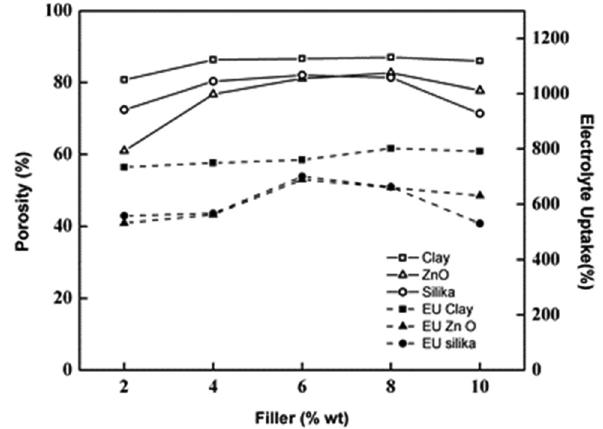
Figure 2: Porosity ( % ) and electrolyte uptake ( % ) of PVDF membrane with various types of fi